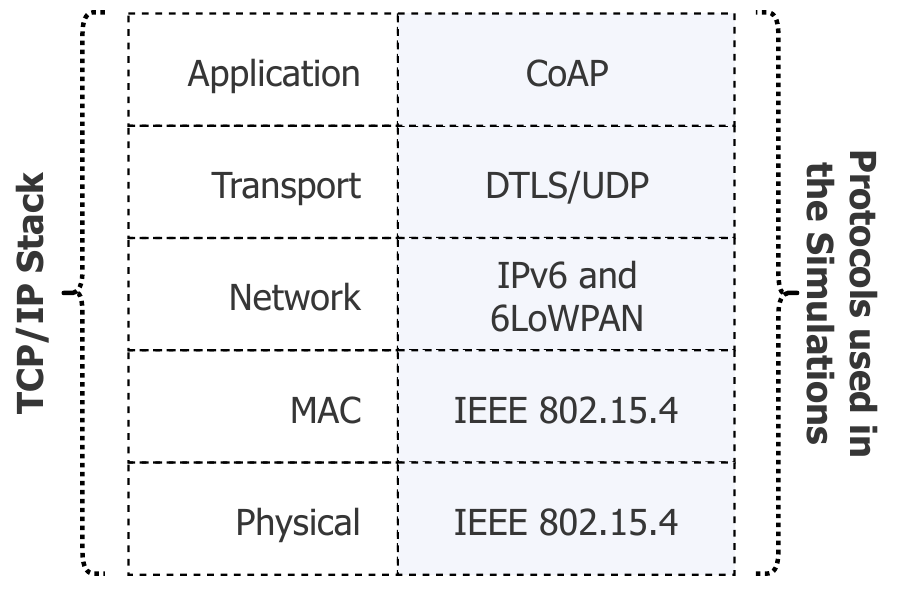
Figure 8. Network